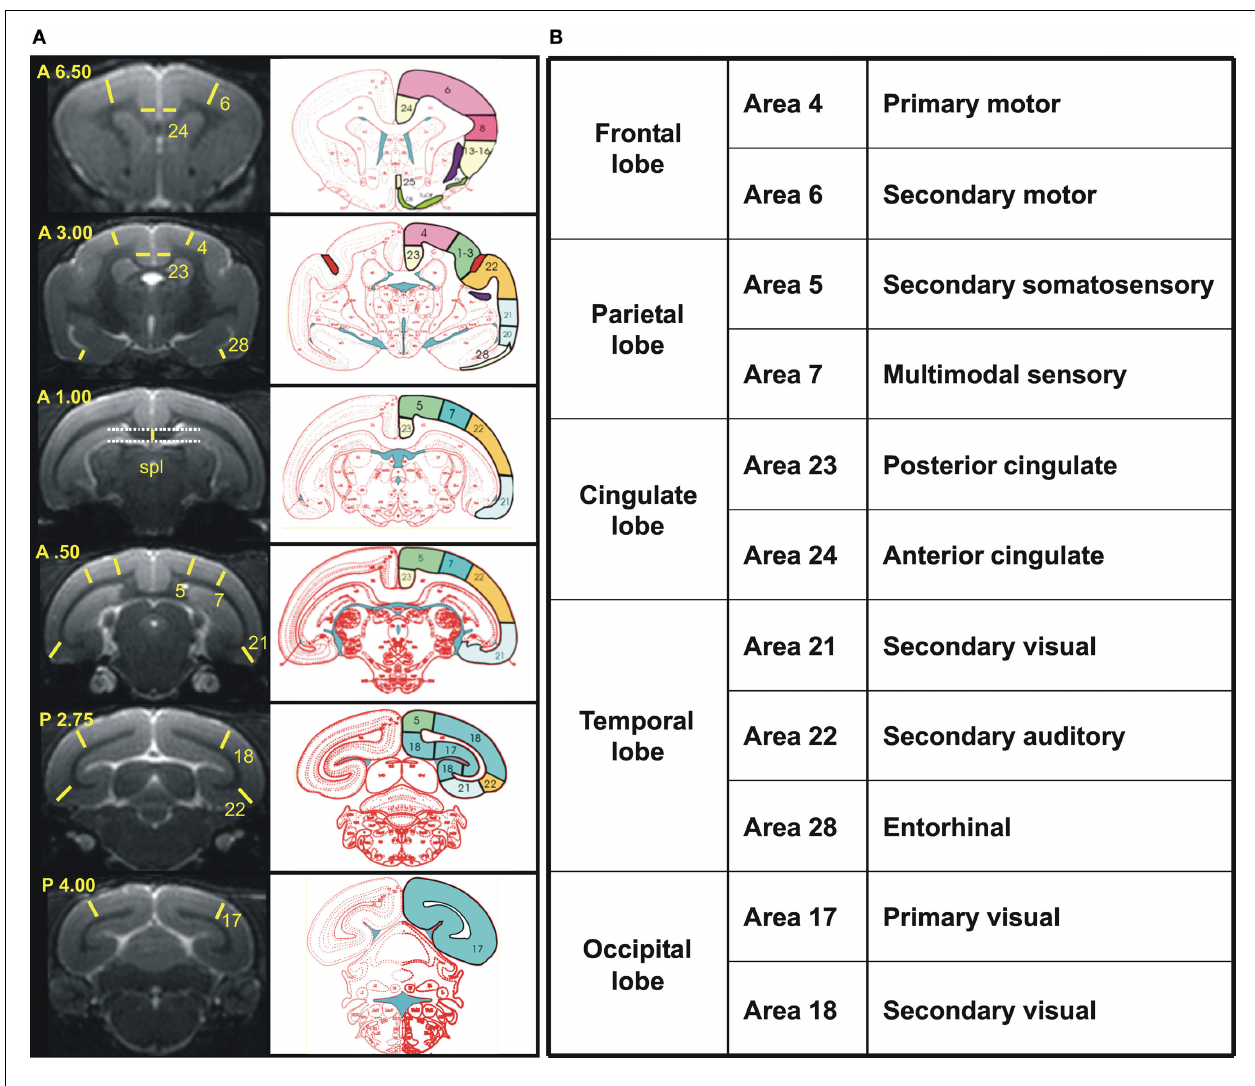
FIGURE 2 | (A) Reference coronal slices used to measure cortex and splenium thickness in cortical regions. Left, Views of the six coronal MR images taken into account with yellow lines and numbers indicating the precise localization of each measure and the cortical area measured, respectively. Coordinates based on the stereotaxic brain atlas of Bons et al.